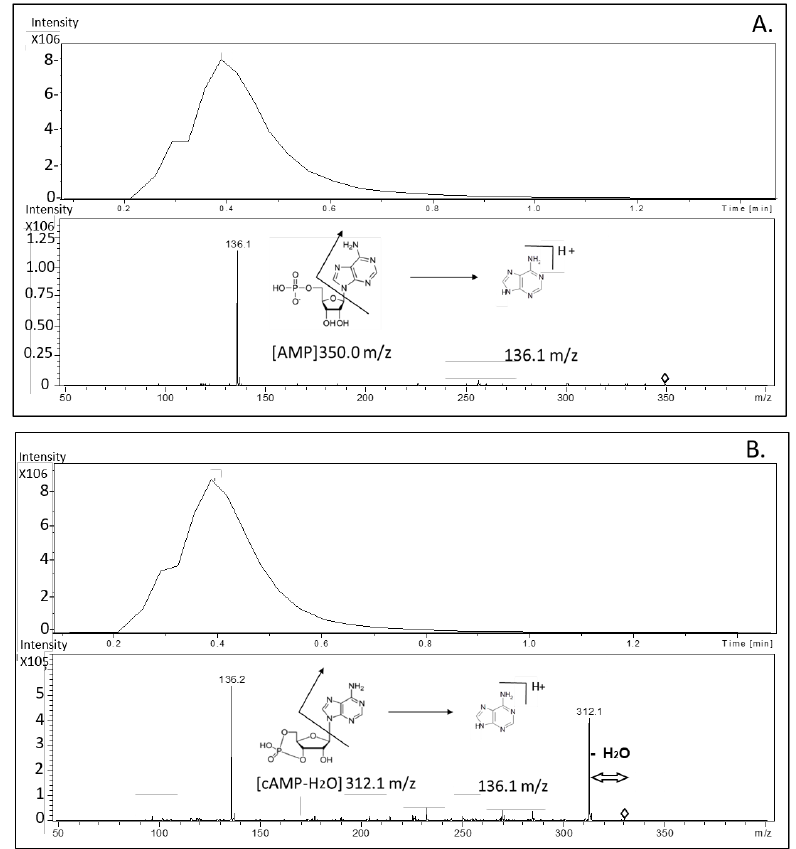
Figure 2. Representative chromatograms and mass spectrum obtained from tandem mass (MS / MS) analysis. Panel ( A ) and ( B ) show chromatogram peaks and mass spectrum from adenosine monophosphate (AMP) and cyclic adenosine monophosphate (cAMP) fragmentation,